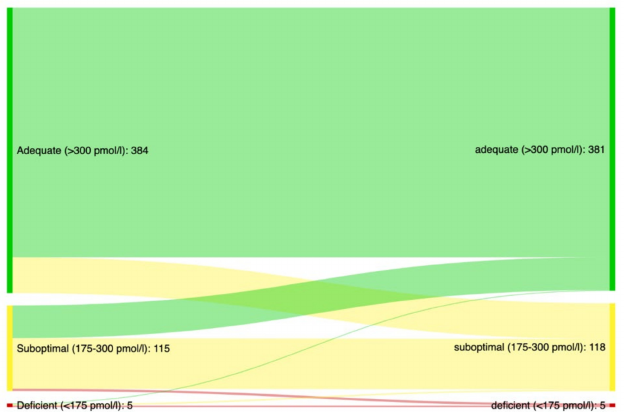
Figure 1. Distribution of vitamin B12 status in the first and second annual assessments. This figure displays the changes in vitamin B12 status categories from the first (left) to the second (right) assessment for participants with at least two vitamin B12 measurements.